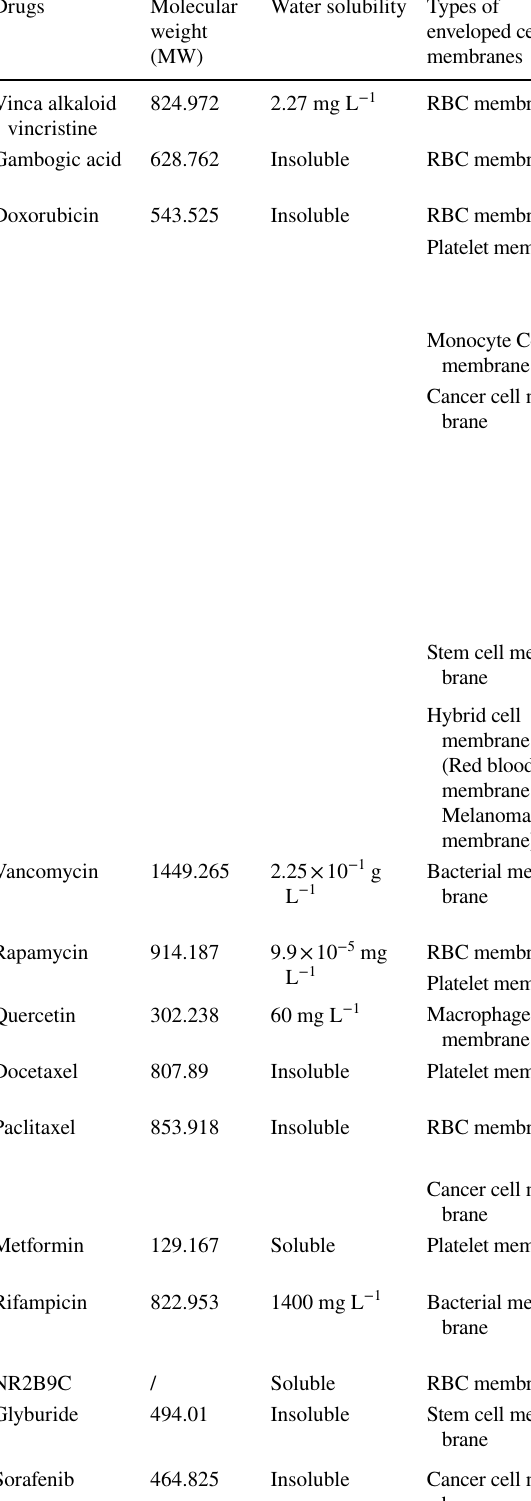
Table 3 A summary of model drugs used in cell membrane coating technology‑related research